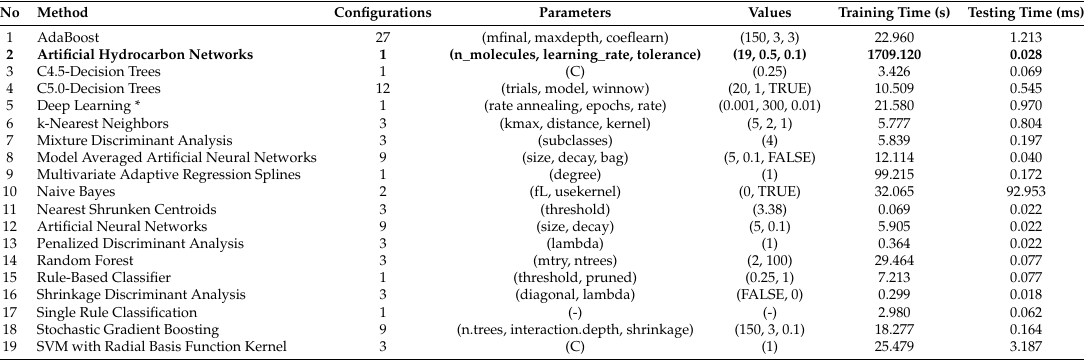
Table 5. Configuration parameters for building suitable activity models using the caret package in R. Other parameters of the method marked with (*) are: Activation_function = hyperbolic tangent, hidden_layers = (200, 250, 200), balance_classes =